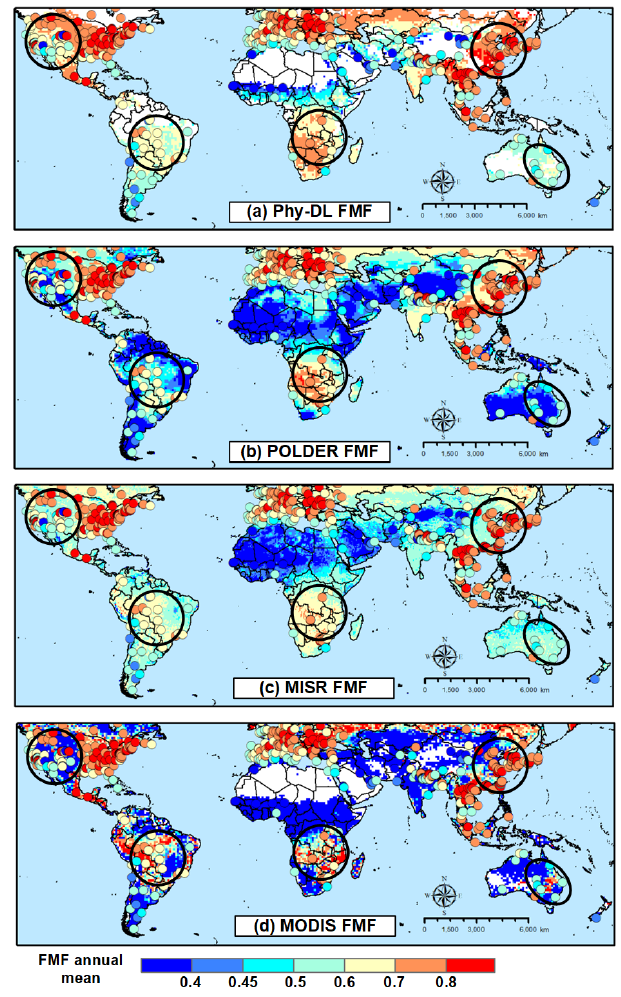
Figure 11. Annual mean FMFs based on (a) Phy-DL, (b) POLDER, (c) MISR, and (d) MODIS. The colored dots show annual mean AERONET FMFs. Areas outlined in black circles show regions with noticeably large differences in the FMF esti- mates. Only those pixels with over 120 retrievals per year were considered in the Phy-DL estimation. Data from 2008 to 2013 were